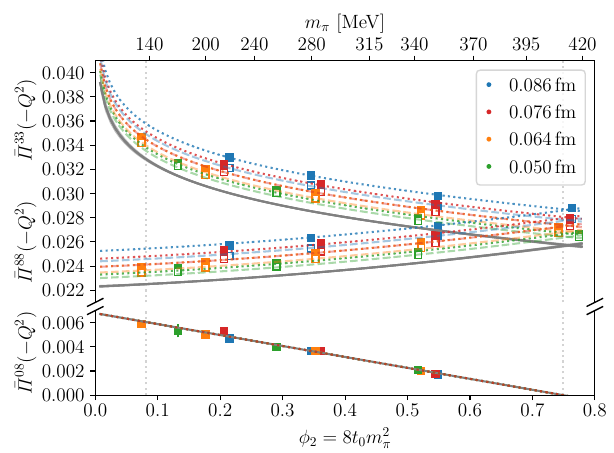
Figure 6 . Plot of ¯ Π 33 ( − Q 2 ) , ¯ Π 88 ( − Q 2 ) (left) and ¯ Π 08 ( − Q 2 ) (right) at Q 2 = 1 GeV 2 on different ensembles as a function of the pion mass, together with the results of the combined fit. With respect to the values in table 4, the data points in the plot include a small shift to the same value of φ 4 . Filled symbols and dotted lines denote the conserved-local discretization, while open symbols and dashed lines denote the local-local